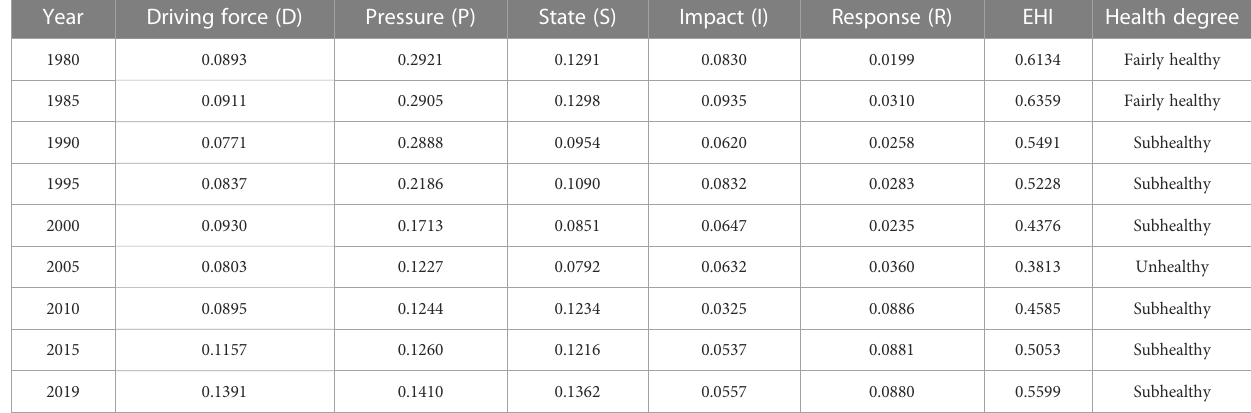
TABLE 4 Ecosystem Health Index (EHI) and health degree of the ecosystem health in Laizhou